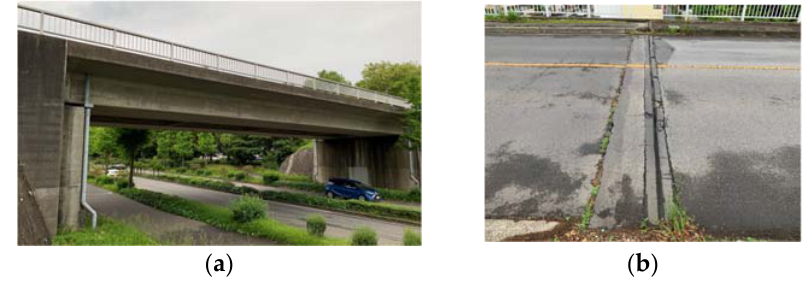
Figure 5. The view of the bridge: ( a ) full view; ( b ) expansion joint [48]. To provide a baseline for comparison with drive-by measurements, the natural fre- quency of Matsumi Bridge is directly measured by installing accelerometers on the